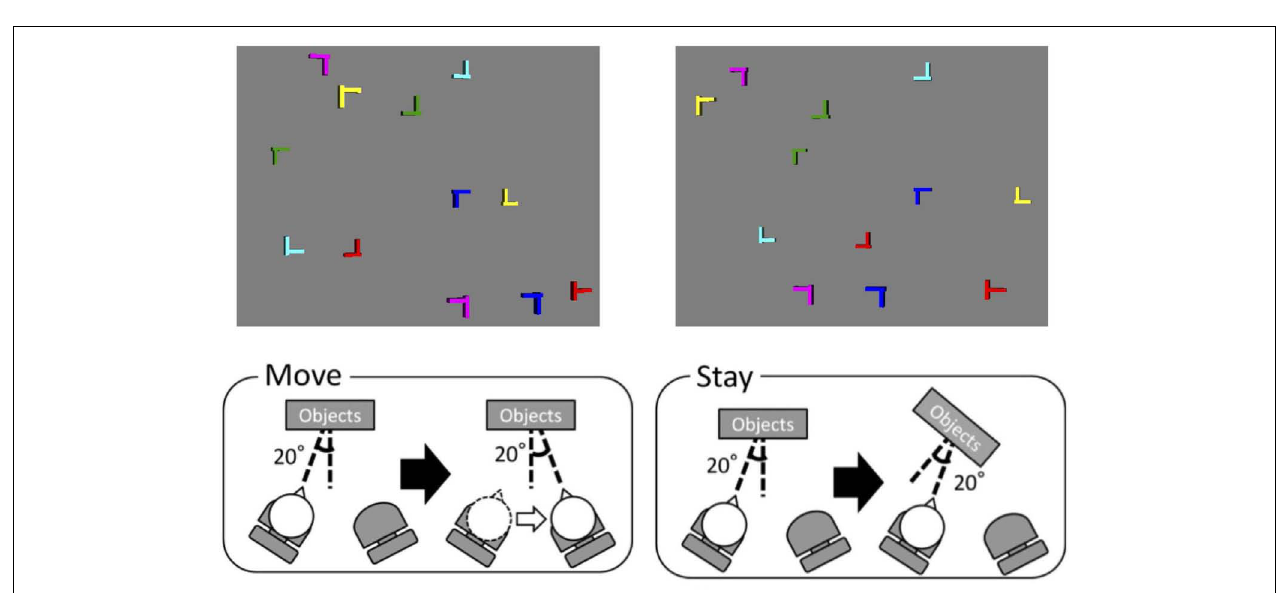
phase was 20˚ left from the surface normal. In the stay condition, the image condition was the same as in the move condition whereas the participant did not change the